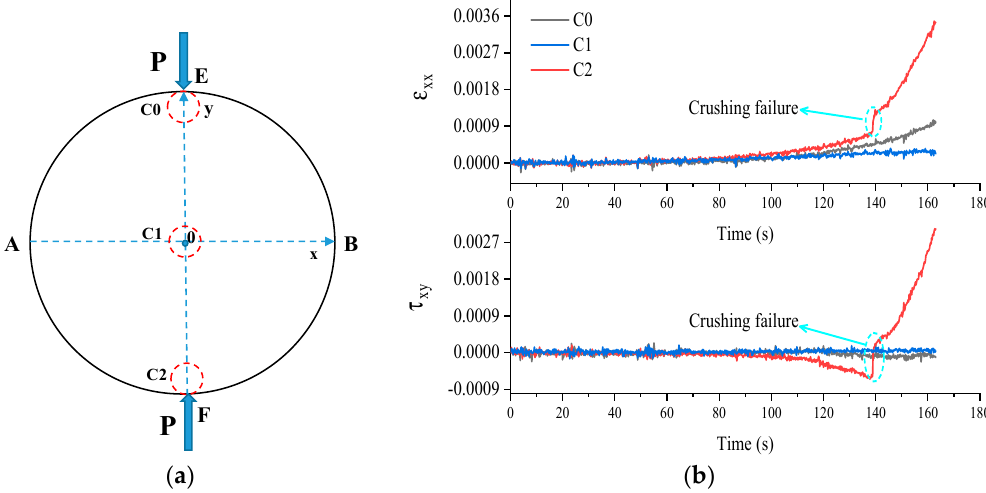
Figure 9. ( a ) Three possible crack initiation positions; ( b ) evolution of tensile and shear strains at these interest areas.